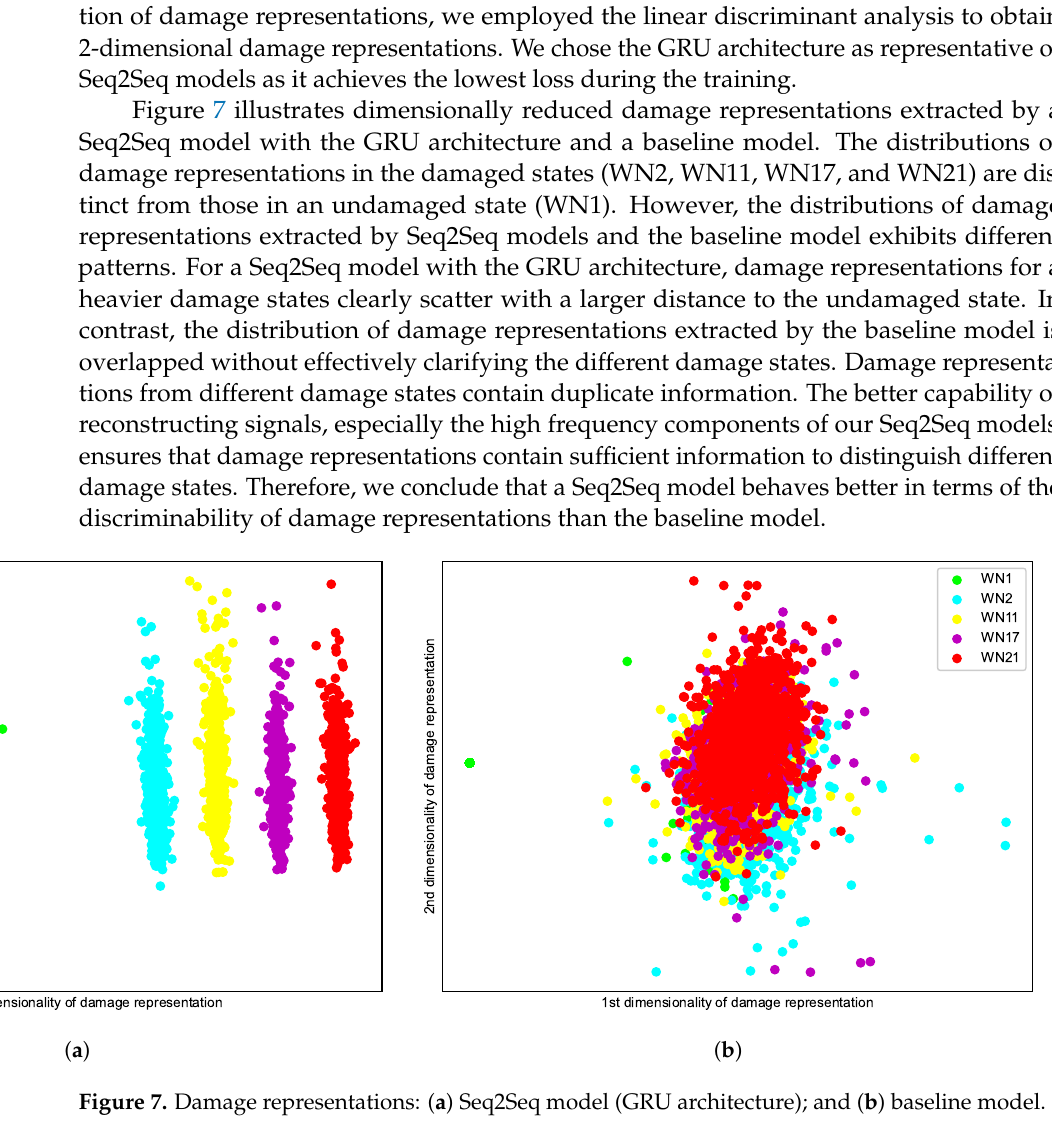
Figure 7. Damage representations: ( a ) Seq2Seq model (GRU architecture); and ( b ) baseline